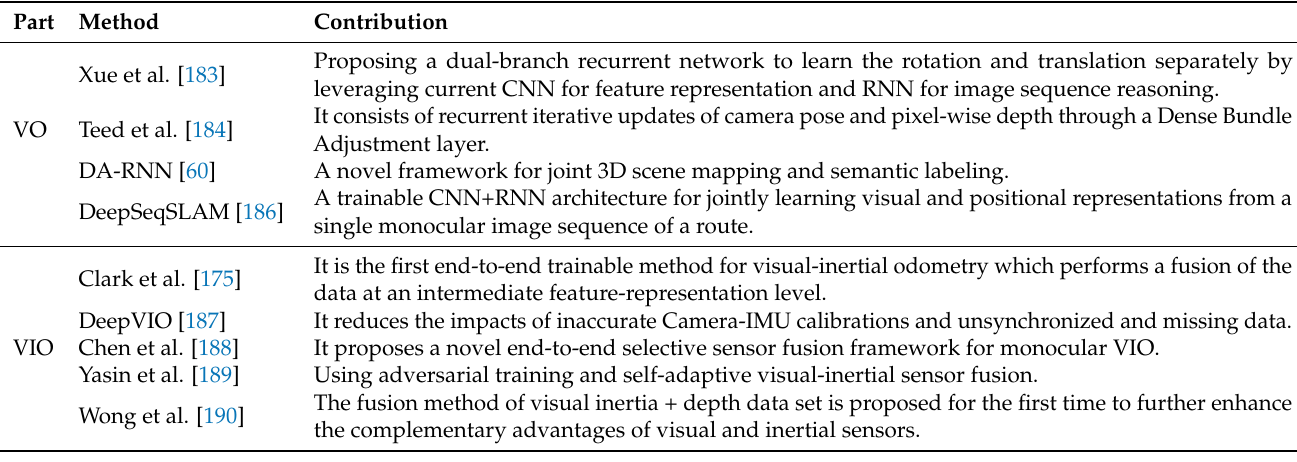
Figure 17. Clark et al. proposed a framework for visual inertia fusion using LSTM. Table 9. RNN used for VSLAM.